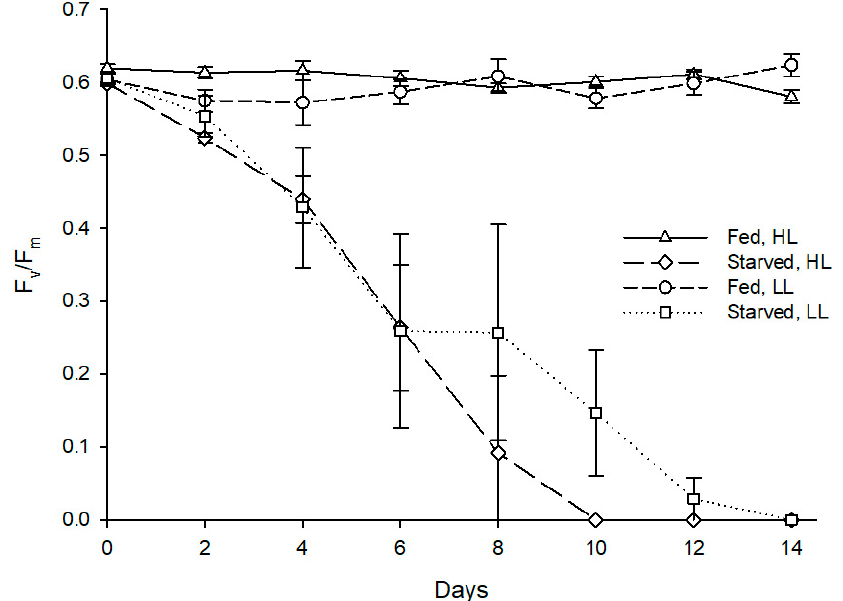
Figure 5. Evolution of fluorescence parameter F v /F m in photosynthetic dinoflagellate endosymbionts hosted by Berghia stephanieae reared under different light intensities and diets (mean ± std. error,